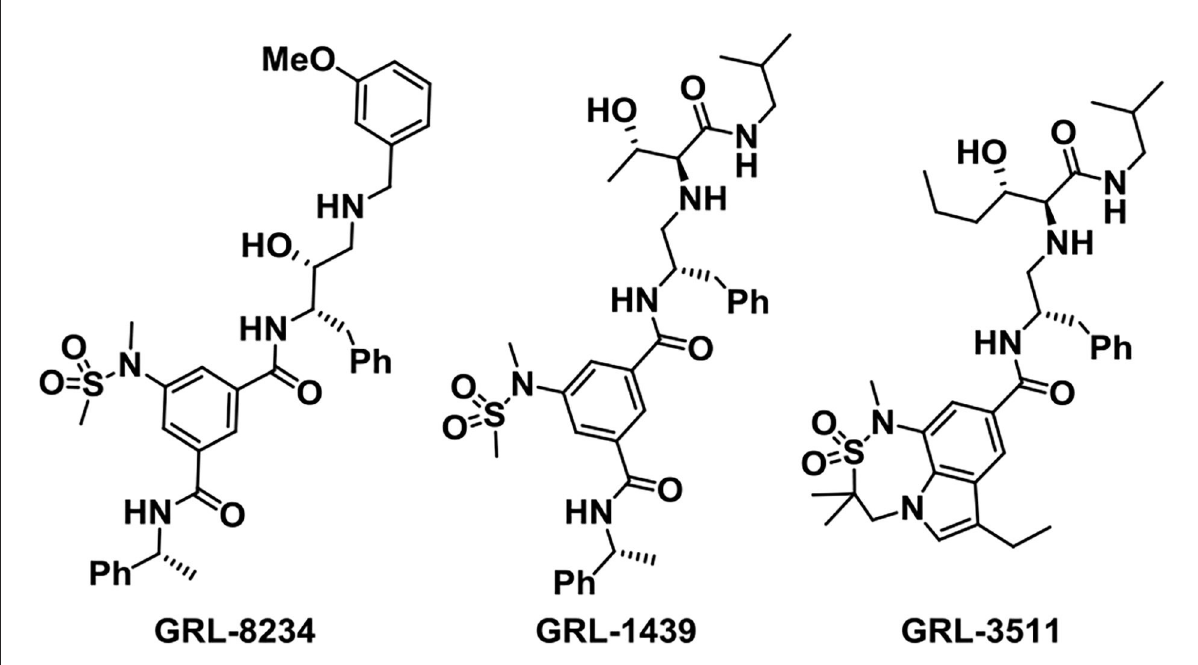
FIGURE5 Structures of GRL-8234, GRL-1439, and